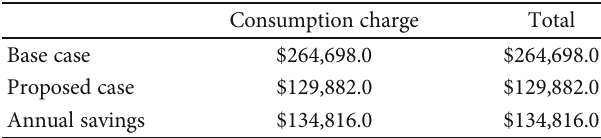
Figure 52: Monthly utility bills for the current and proposed systems for Rwanda. Table 25: Annual utility bills and savings by category